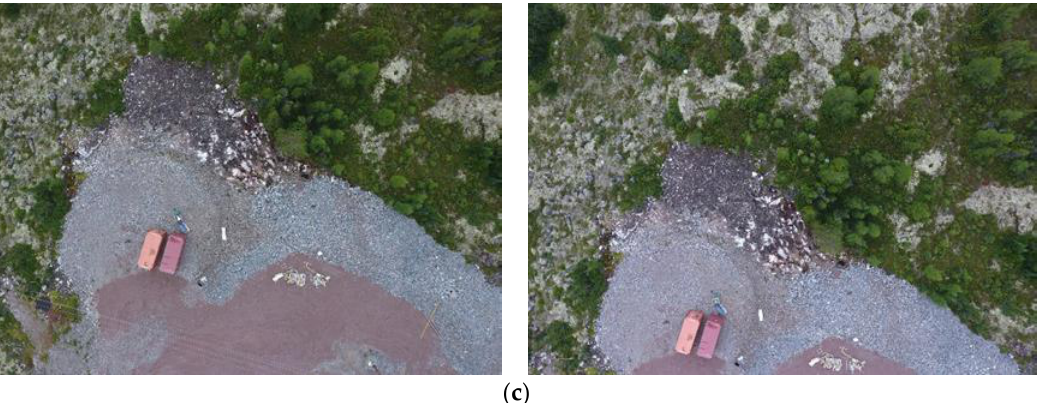
Figure 7. Three different stereo UAV images over dense ( a ), semi-dense ( b ), and sparse ( c ) forestry areas.